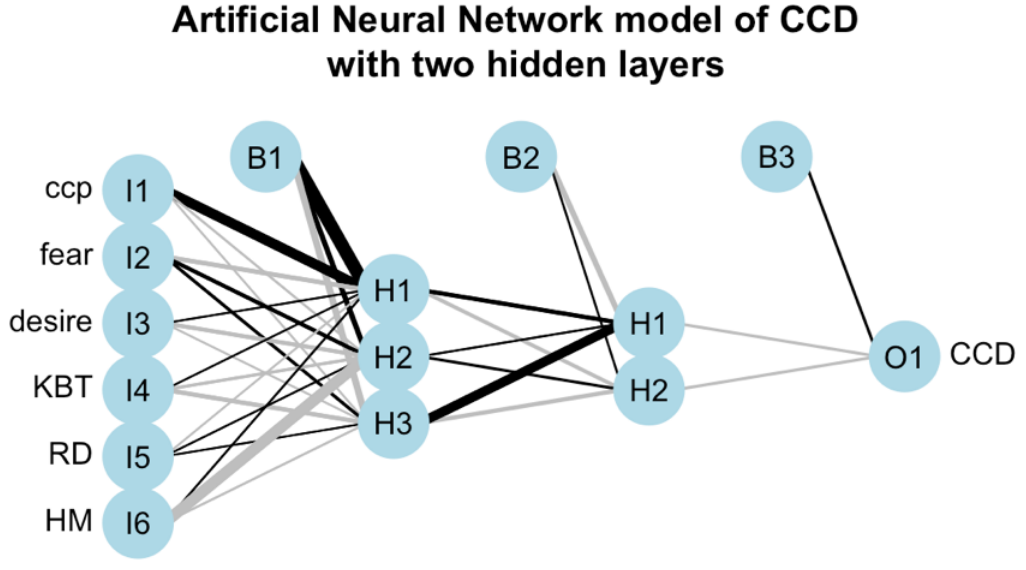
Figure 3. The neural network interpretation diagram of the ANN model with two hidden layers of numbers of CCDs at the simulation